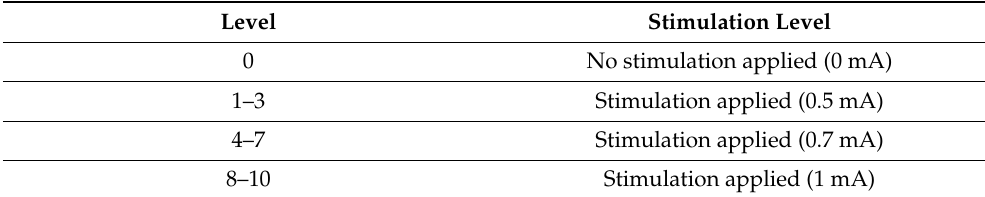
Table 1. The electrical current of each